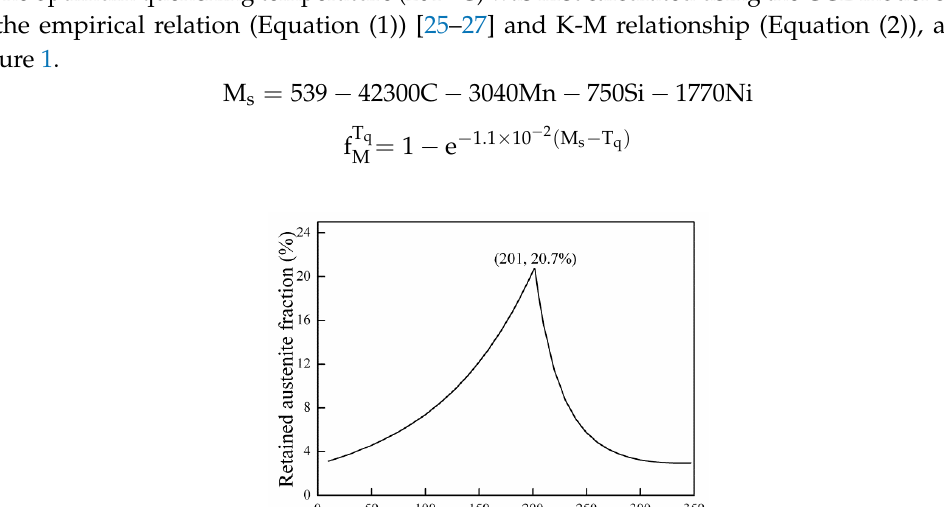
Table 1. Phase transformation parameters.